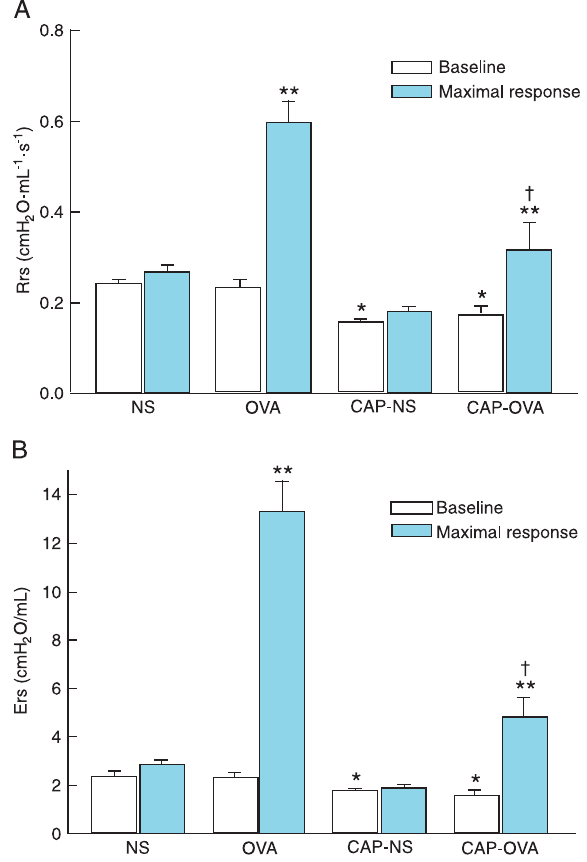
Figure 2. Lung mechanics. Data are reported as means and SEM of the baseline and maximal responses of respiratory system re - sistance (Rrs) and elastance (Ers) after antigen challenge. In the OVA group, guinea pigs were exposed to seven inhalations with ovalbumin. In the CAP-OVA group, animals received a high dose of capsaicin 14 days before the beginning of the ovalbumin inha- lations. The control groups received inhalation with normal saline and pretreatment with vehicle (NS group) or capsaicin (CAP-NS group). *P < 0.001 compared to the baseline data of the NS and OVA groups, respectively; **P < 0.05 compared to maximal re - sponse of NS group; † P < 0.05 compared to maximal response of OVA group. Statistical analysis was done by two-way analysis of variance, and multiple comparisons were made using the Holm- Sidak